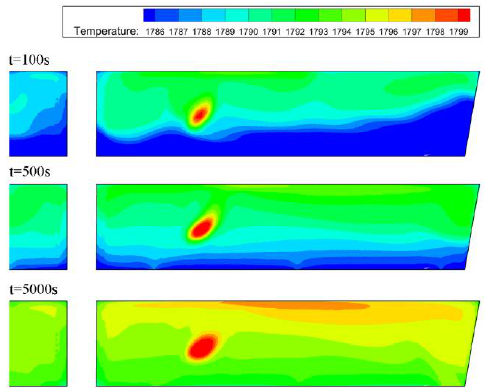
Figure 17. Temperature fields of vertical plane passing through all the outlets.